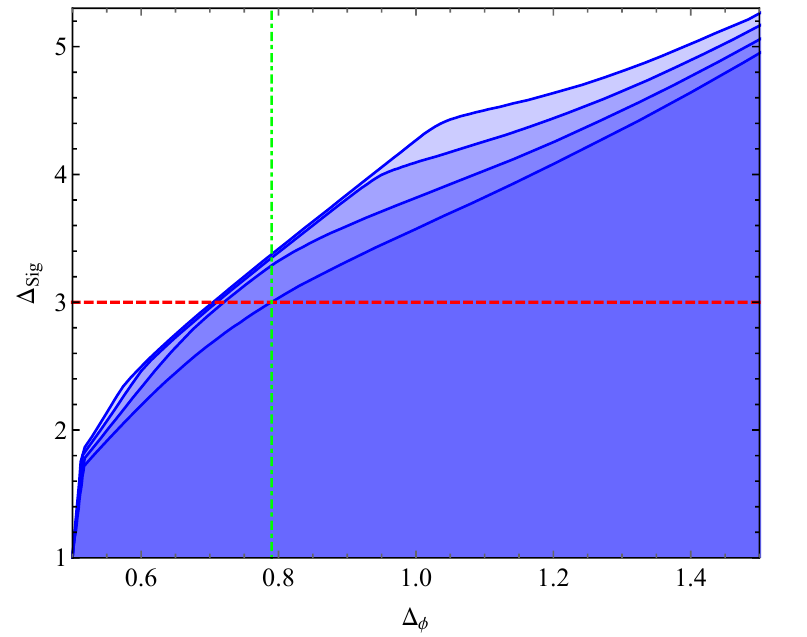
Figure 1 . Upper bounds ( Λ = 31 ) on the scaling dimensions of the SO( N ) singlet scalars. N = 5 , 6 , 7 , 8 from bottom to top. The dot-dashed green line gives a left cut for the SO(5) singlet bound with a gap assumption ∆ Sig > 3 .